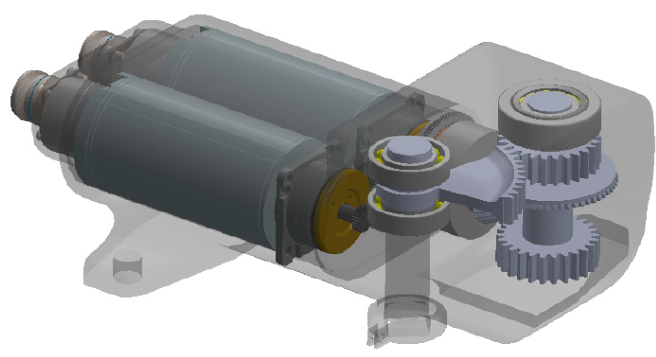
Figure 17. General view of the electromechanical GVA.